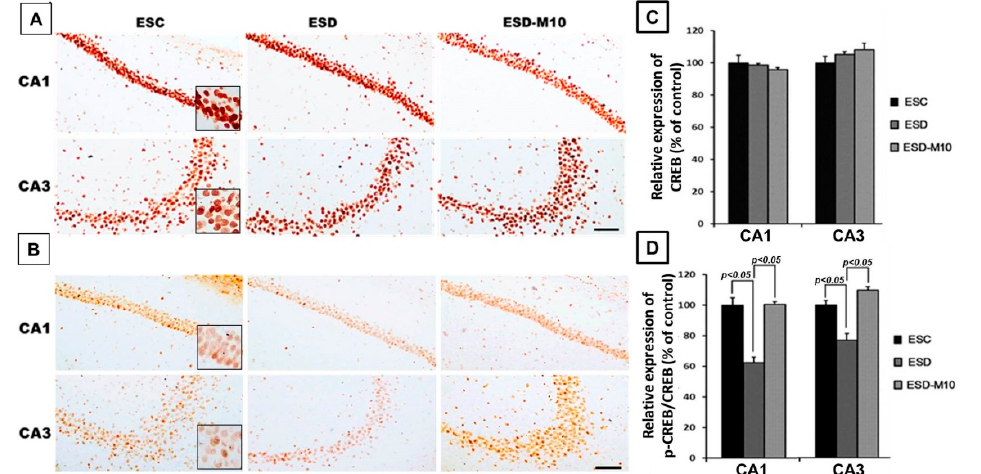
Figure 5. Photomicrographs ( A , B ) and histogram ( C , D ) show the extent of CREB and p-CREB activities in the CA1 and CA3 region of the hippocampus. Note that the protein expression levels of p-CREB markedly increased in the ESC and ESD-M10 groups when compared with the ESD group ( p < 0.05). There was no difference between the three groups in terms of CREB protein expression in the hippocampus. Scale bars: 300 μ m.